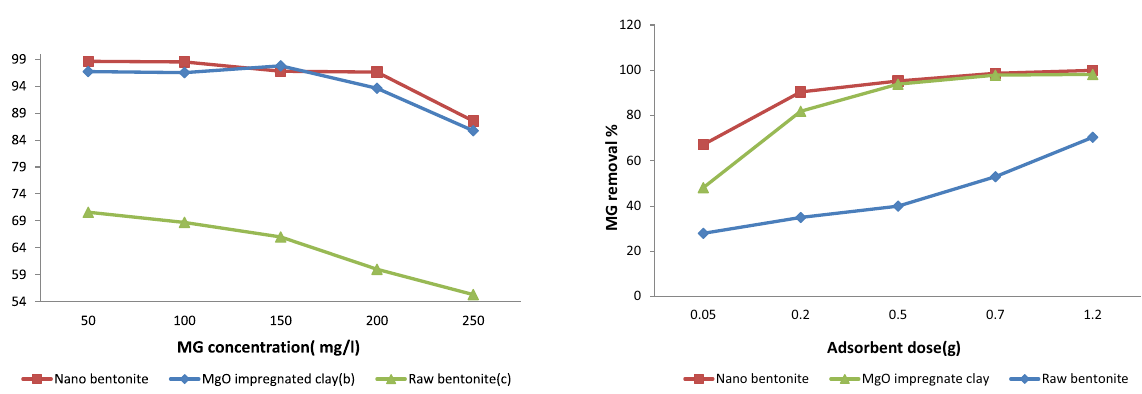
Fig. 10 Effect of adsorbent dose on MG dye removal by a nano-bentonite, b MgO impregnated clay and c raw